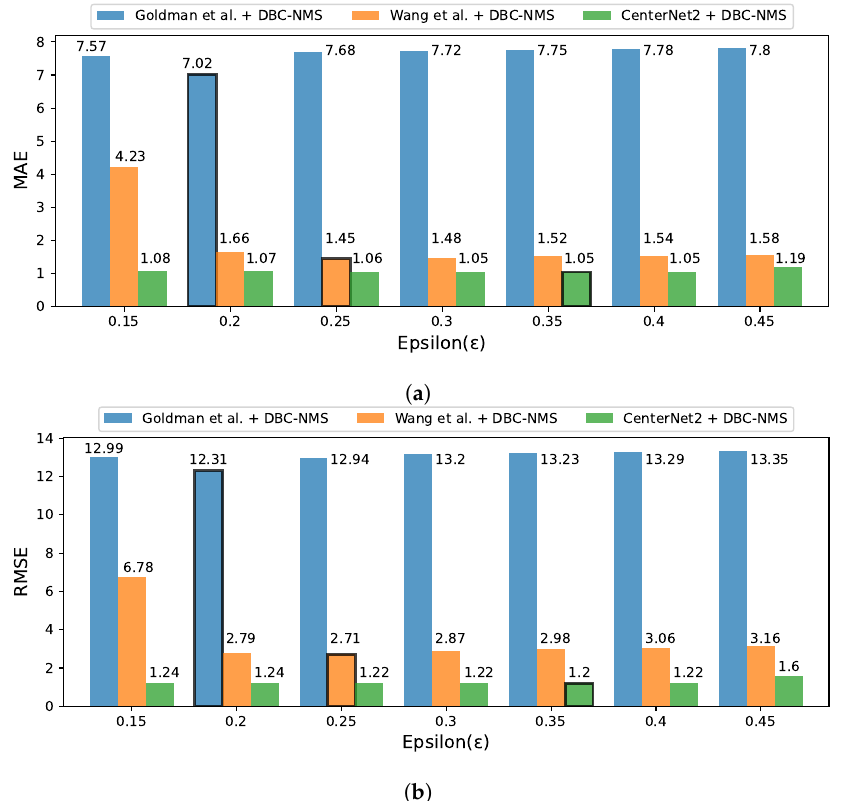
Figure 10. Sensitivity analysis of parameter ε for DBC-NMS. ( a ) MAE for various ε values. ( b ) RMSE for various ε